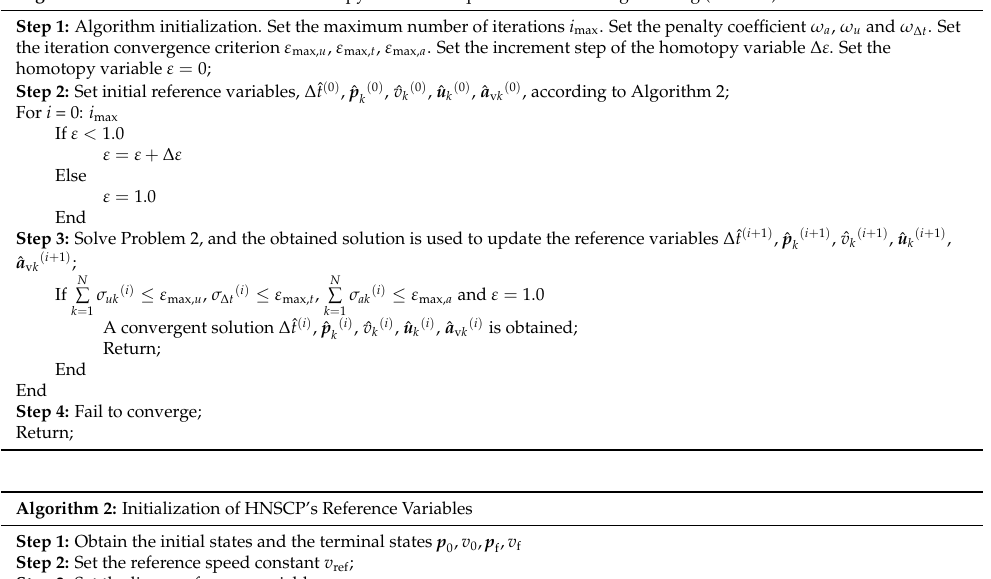
Algorithm 1 : Online Procedure of Homotopy Network Sequential Convex Programming (HNSCP)